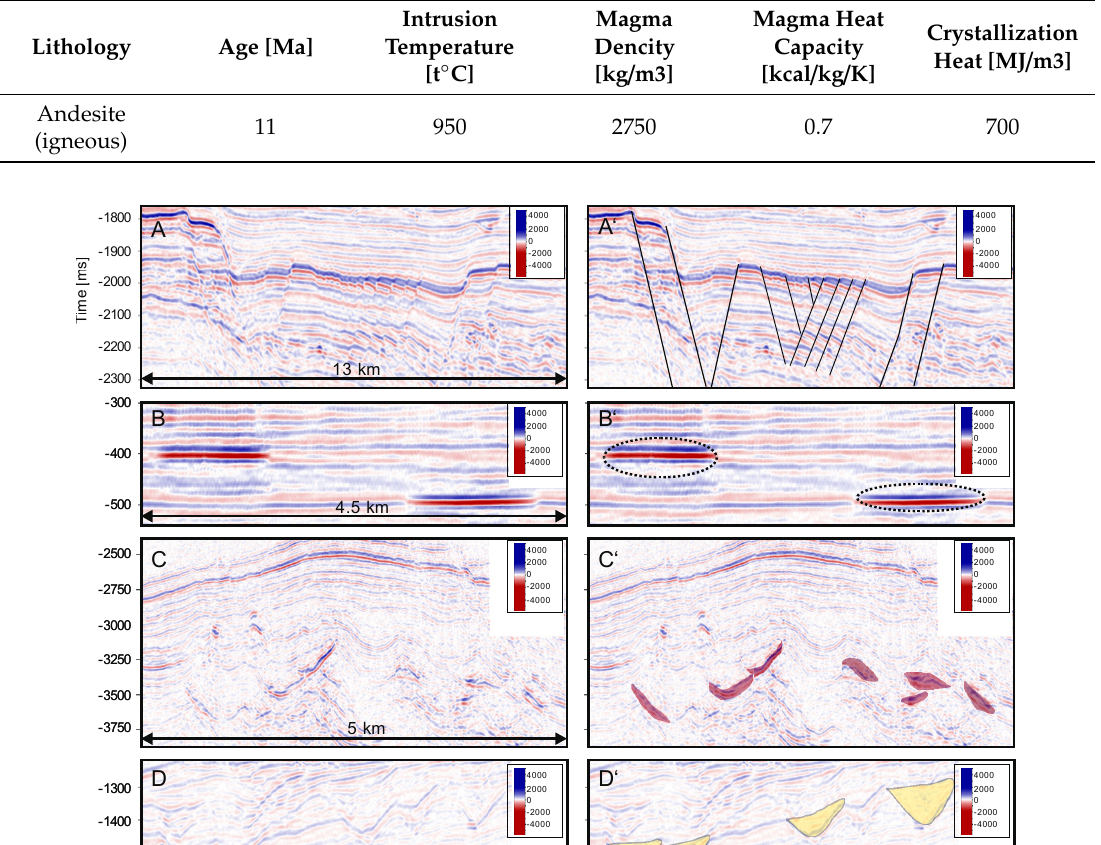
Table 4. Parameters of the igneous intrusion, used in Intrusion tool in Petromod for modeling magmatic activity.